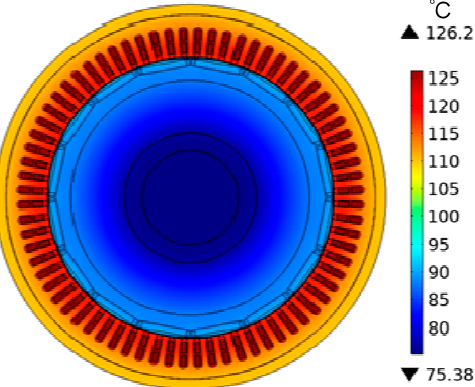
Figure 14. Temperature distribution with the bidirectional coupled method.